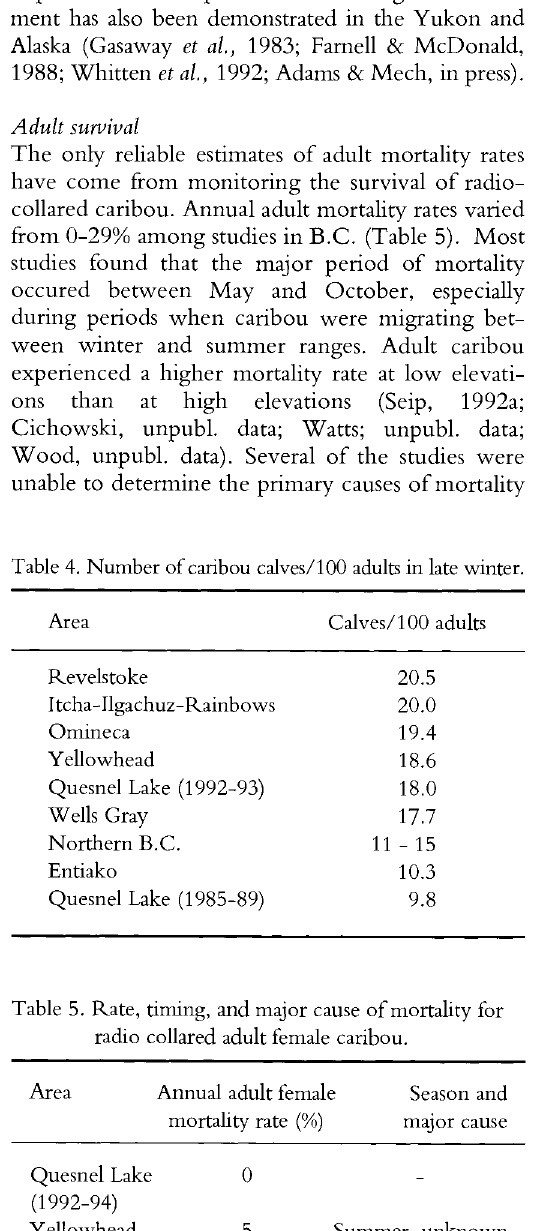
Table 5. Rate, timing, and major cause of mortality for radio collared adult female